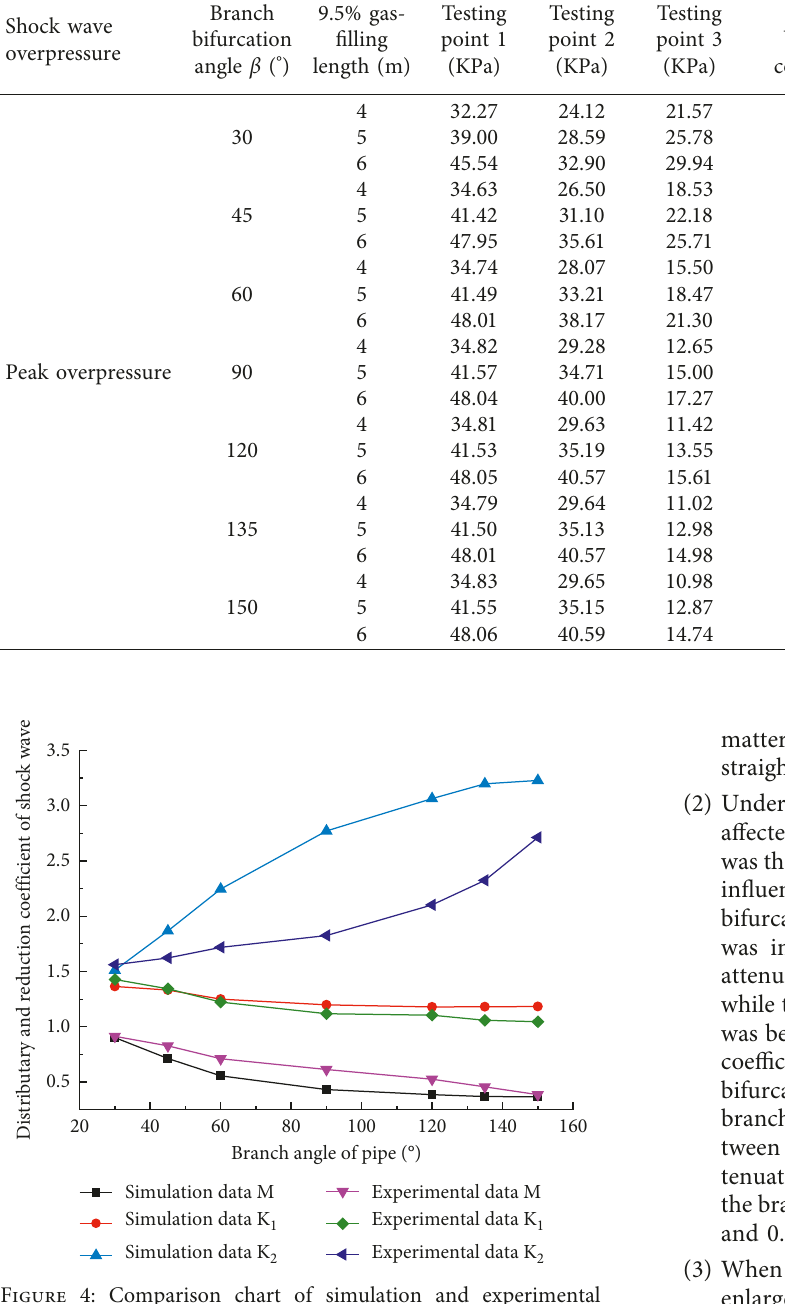
Figure 4: Comparison chart of simulation and experimental